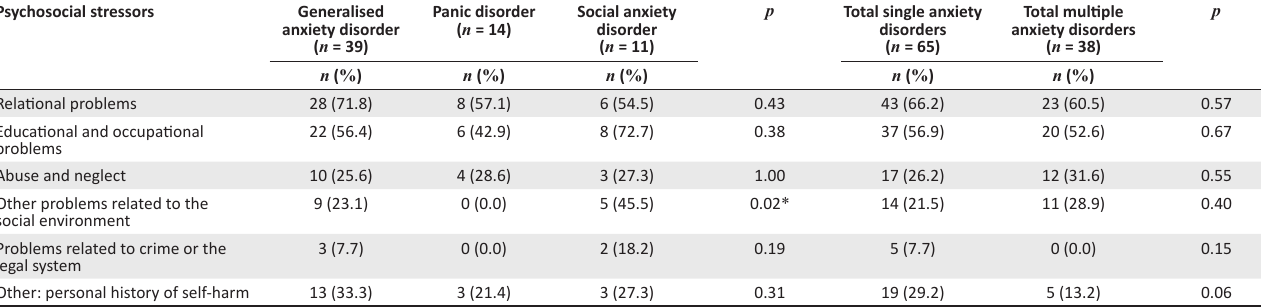
TABLE 4: Psychosocial stressors for patients with a single anxiety diagnosis or multiple anxiety